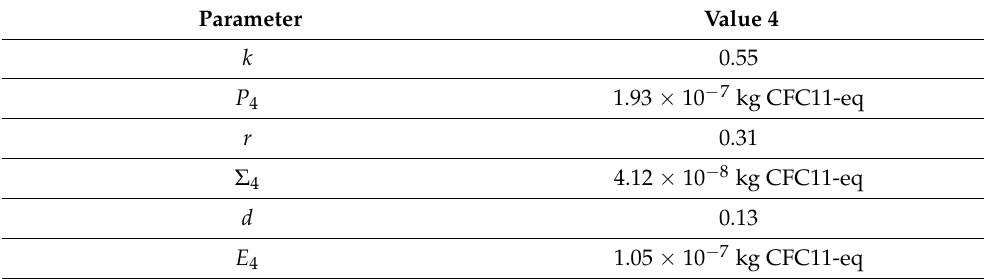
Table 4. Parameter values of the ozone depletion